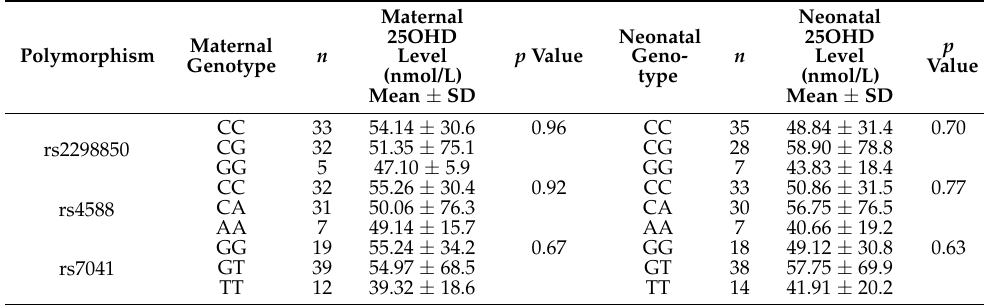
Table 3. Mean concentrations of maternal and neonatal 25(OH)D according to VDBP polymorphisms.